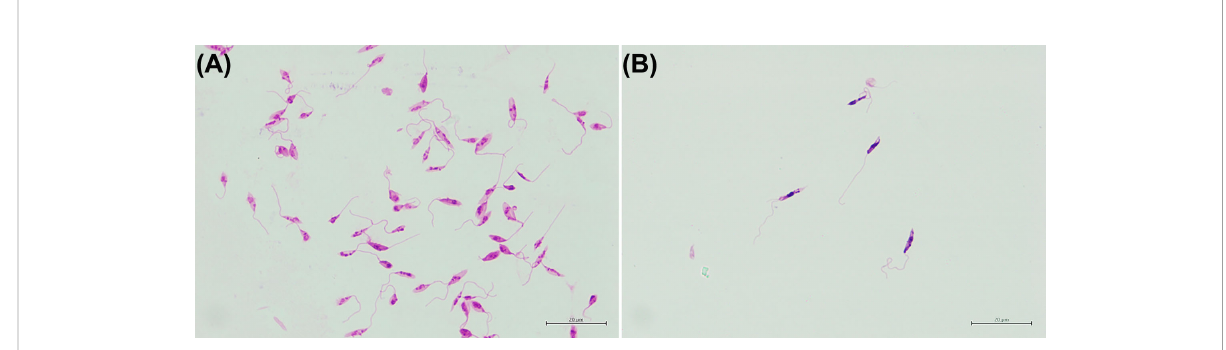
FIGURE 2 Representative images of (A) Stationary phase promastigotes from the SIM, pH 5.0, DBU and 10% (v/v) FBS culture medium and (B) PNA non- agglutinated